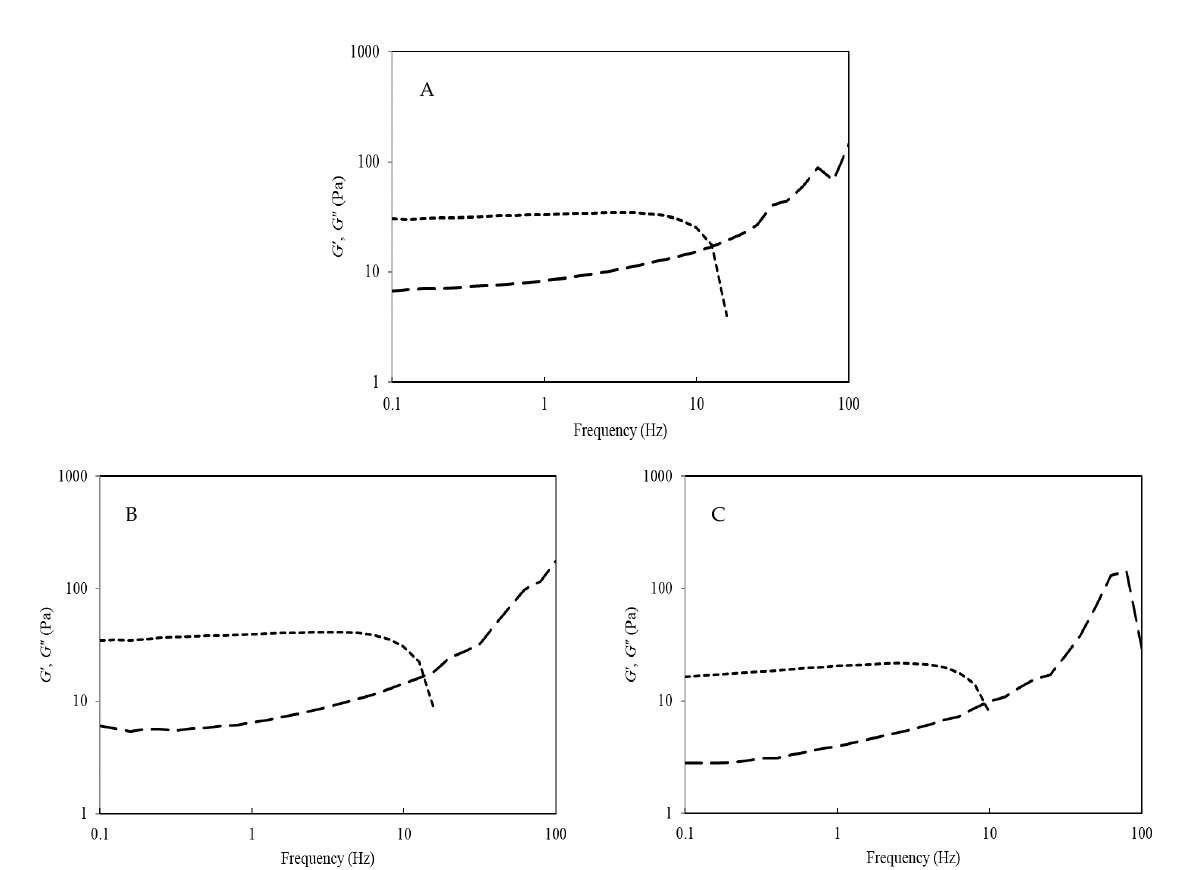
Figure 7. Elastic ( G ′ ; ----) and viscous ( G ″ ; ─ ─ ) moduli of soy protein isolate dispersions at pH 2.0 ( A ), pH 6.9 ( B ), and pH 9.0 ( C ), measured as a function of frequency (Hz) at 40 °C.